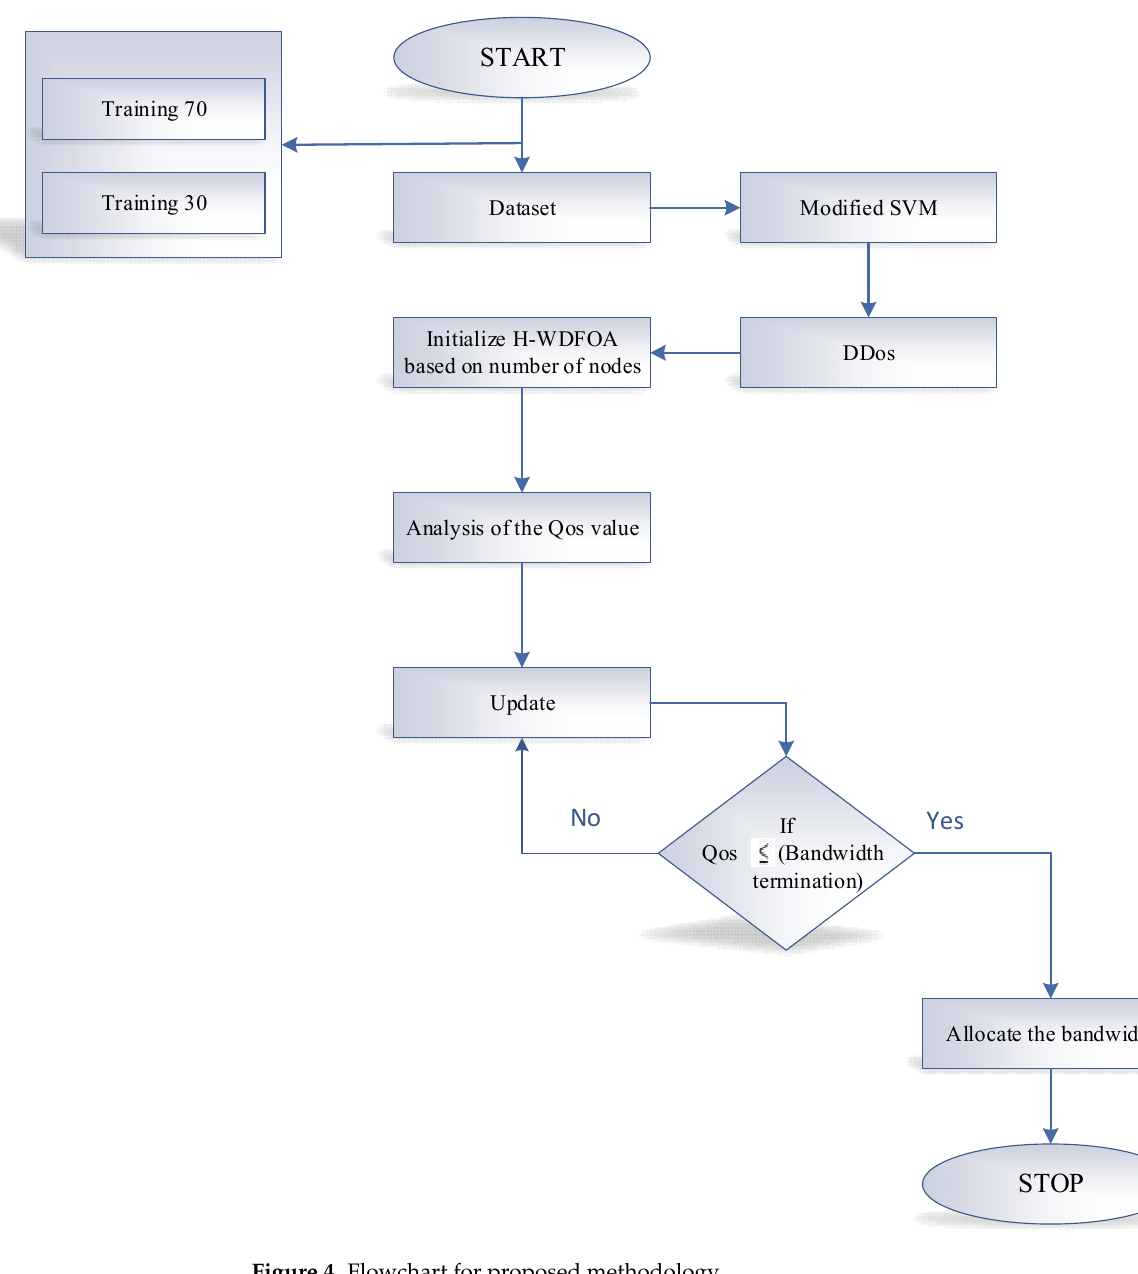
Figure 4. Flowchart for proposed methodology.